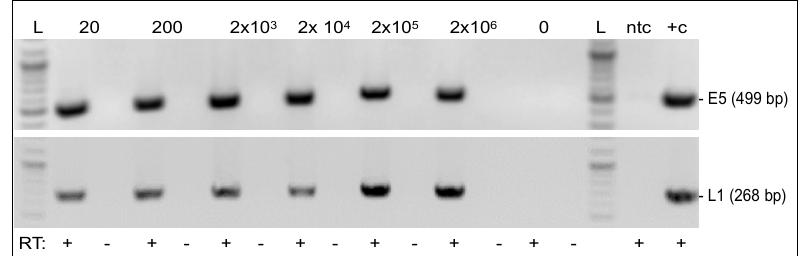
Figure 4. RT-PCR-mediated detection of BPV1 E5 and L1 mRNA from infected cells. BPV1 E5 and L1 RT-PCR from total, DNase-digested RNA of infected equine fibroblasts (P11). 20-2 × 10 6 /0: number of virions used for in vitro infection of cells; ntc: no-template control (sterile water); +c: positive control (sarcoid RNA); RT: +, − : reverse transcription performed with (+), or without ( − ) enzyme (controls). L: Gene Ruler DNA Ladder Mix (Thermo Fisher Scientific).